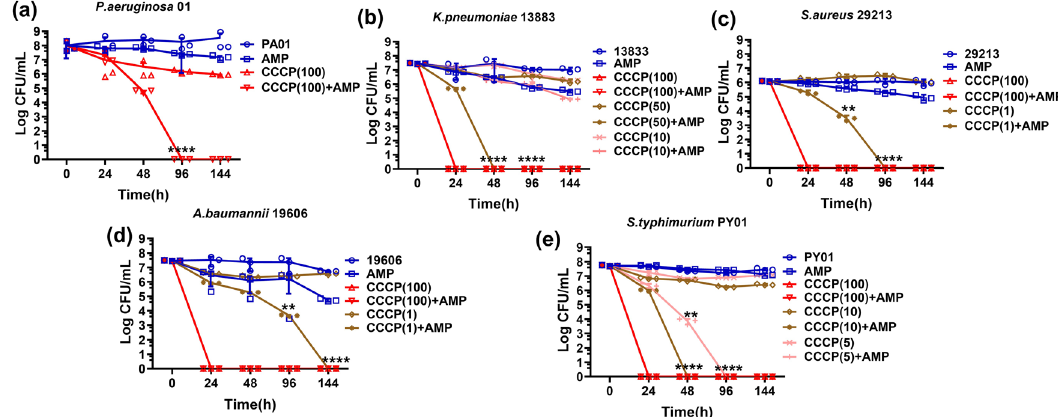
Fig. 5 PMF maintenance is essential for starvation-induced tolerance formation in major Gram-negative and Gram-positive bacteria. Changes in the size of antibiotic-tolerant subpopulation in P. aeruginosa ( a ), K. pneumoniae ( b ), S. aureus ( c ), A. baumannii ( d ) and S. typhimurium ( e ) which had been starved for 24 h, followed by treatment with 10× MIC ampicillin (AMP) alone (Supplementary Table. 2), CCCP alone and CCCP in the presence of 10× MIC ampicillin. CCCP(100), 100 μ M CCCP; CCCP(50), 50 μ M CCCP; CCCP(10), 10 μ M CCCP; CCCP(5), 5 μ M CCCP;CCCP(1), 1 μ M CCCP. n = 3 biologically independent experiments. P values were tested between CCCP + AMP and CCCP with the same concentration at indicated time points. **indicate a P value of <0.01, ****indicate a P value of <0.0001 by two-tailed Student ’ s test. Error bar represents standard deviation.